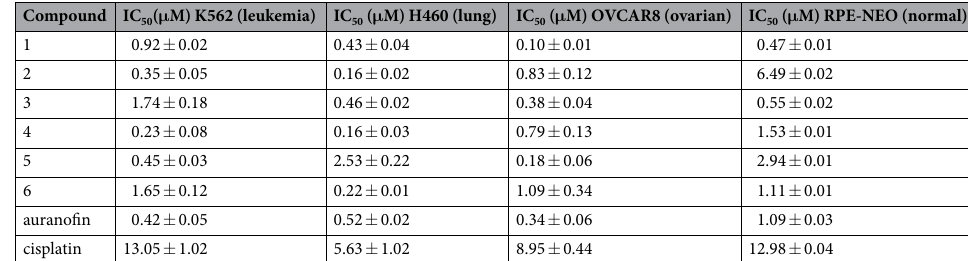
Table 2. IC 50 Values ( µ M) of 1–6 , cisplatin, and auranofin against a panel of cancer cell lines after 72 h exposure. Cisplatin stock was prepared in PBS and gold compounds were freshly prepared in DMSO and used immediately. DMSO concentration was < 1%.